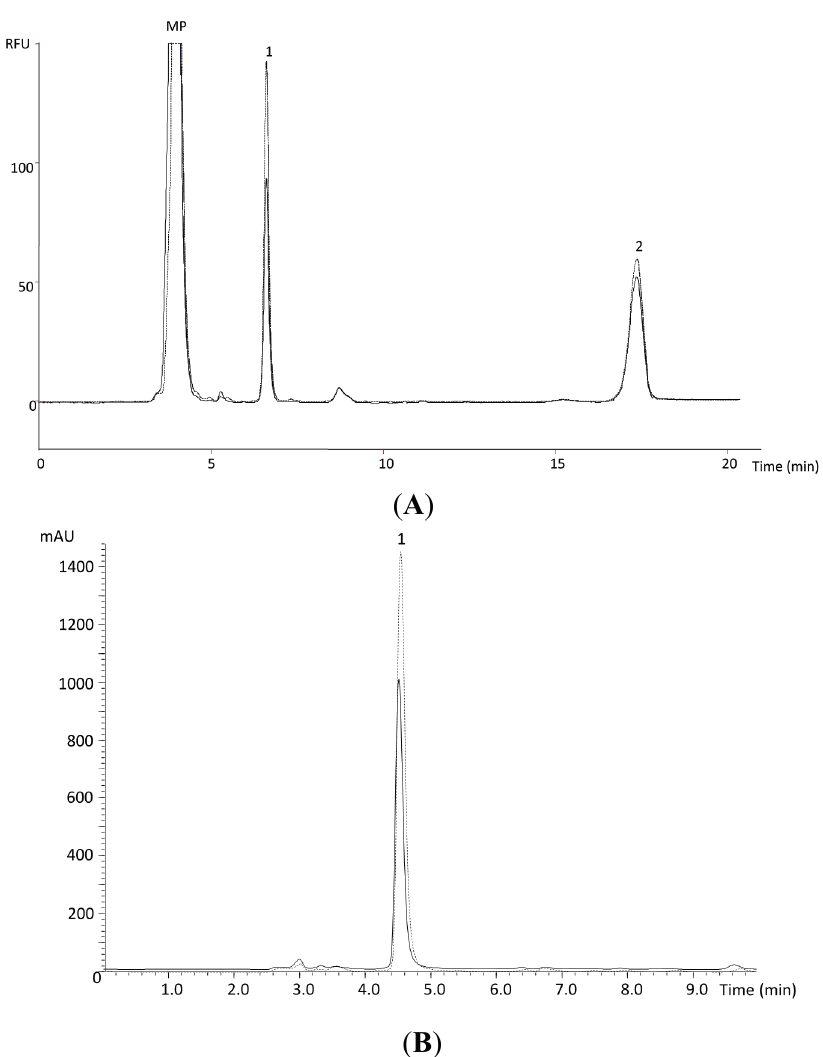
Figure 2. HPLC chromatograms of α -tocopherol [( A ), MP—mobile phase; 1— α -tocopherol; 2—tocol] and ascorbic acid [( B ), 1—ascorbic acid] in the dried pulp of Chislet variety for the year 2011 (----- January and ______